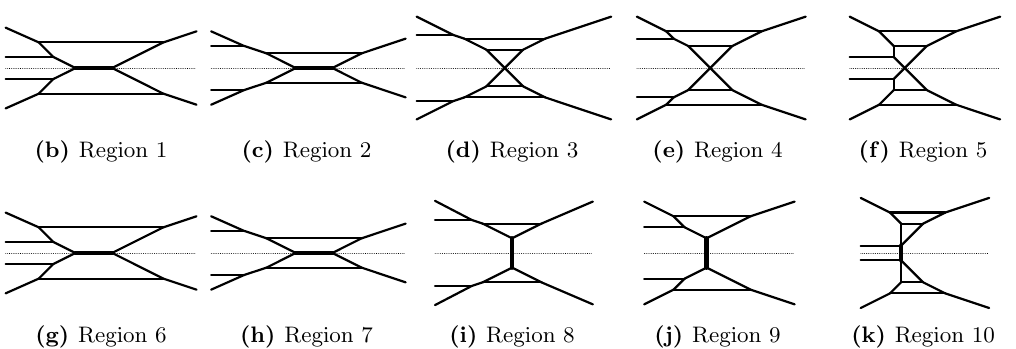
Figure 12. The phase diagram of the E 2 theory. The 5-brane web diagram in each region is depicted in (cid:12)gure